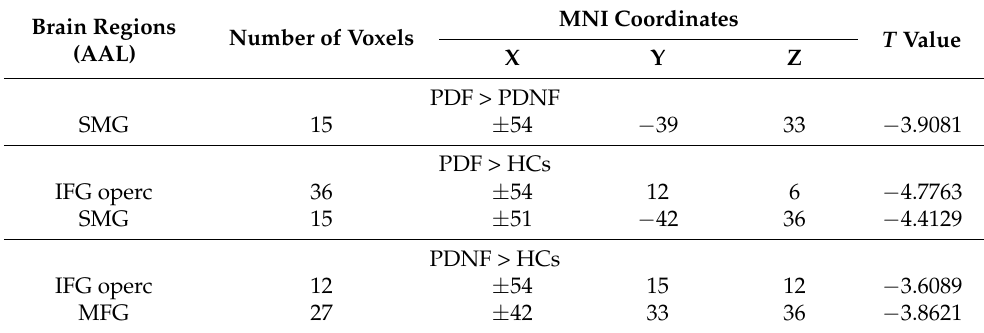
Table 2. Regions showing significant differences in VMHC between groups.